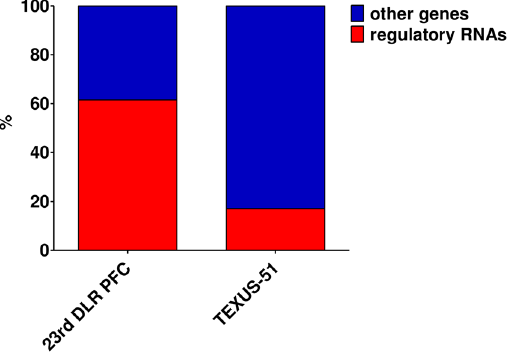
Figure 10. Regulatory RNAs. Percentage of regulatory RNAs that are significantly changed by hypergravity and/or microgravity during the 23 rd DLR parabolic flight campaign (23 rd DLR PFC), and the TEXUS-51 sounding rocket suborbital